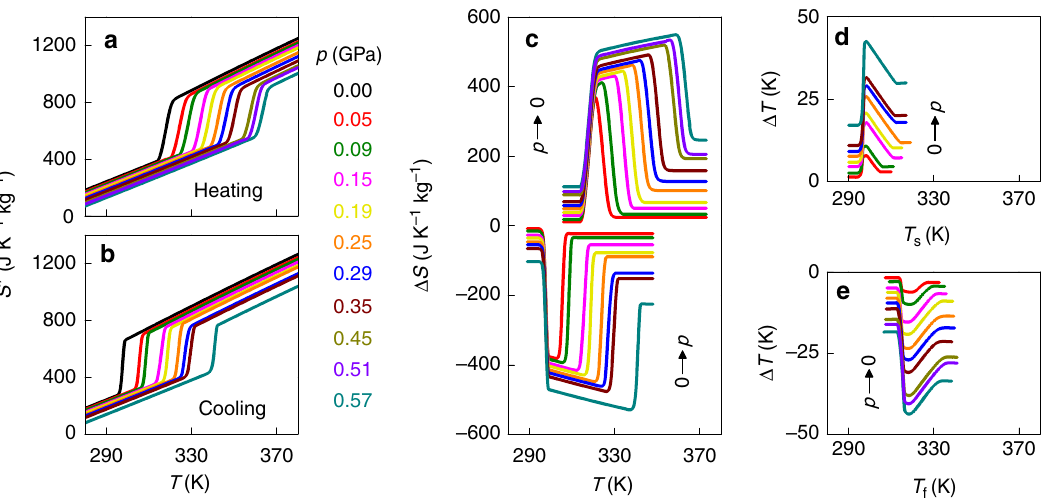
Fig. 3 Colossal barocaloric effects in NPG near room temperature. a , b Entropy S ’ ( T , p ) with respect to the absolute entropy at 250 K and p ~ 0, on a heating and b cooling through the fi rst-order PC-OC phase transition. c Isothermal entropy change Δ S for 0 → p deduced from b , and for p → 0 deduced from a . d Adiabatic temperature change Δ T versus starting temperature T s , for 0 → p deduced from b . e Adiabatic temperature change Δ T versus fi nishing temperature T f for p → 0 deduced from